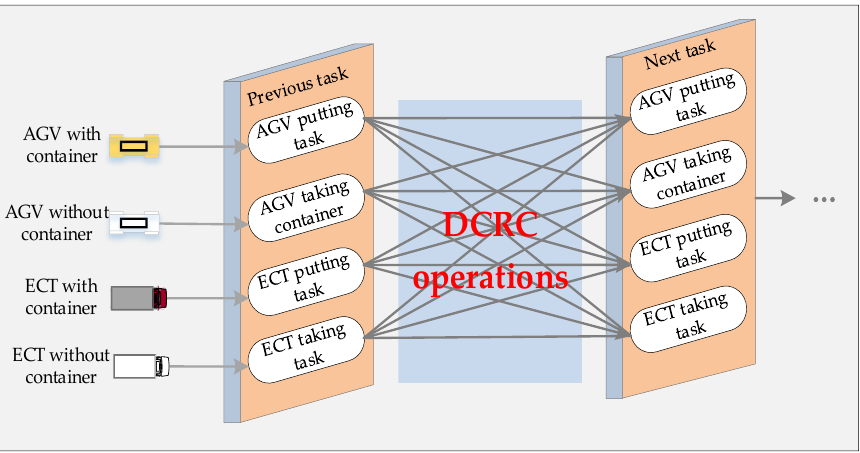
ECT task for the DCRC operation. The numbered circles indicate the order of movement for the DCRC gantry and its spreader.